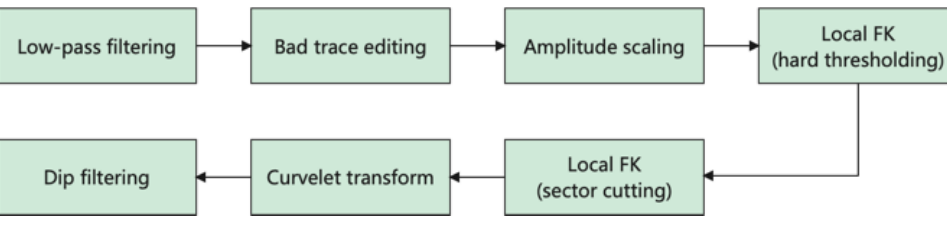
Figure 14. A flow chart showing the processing